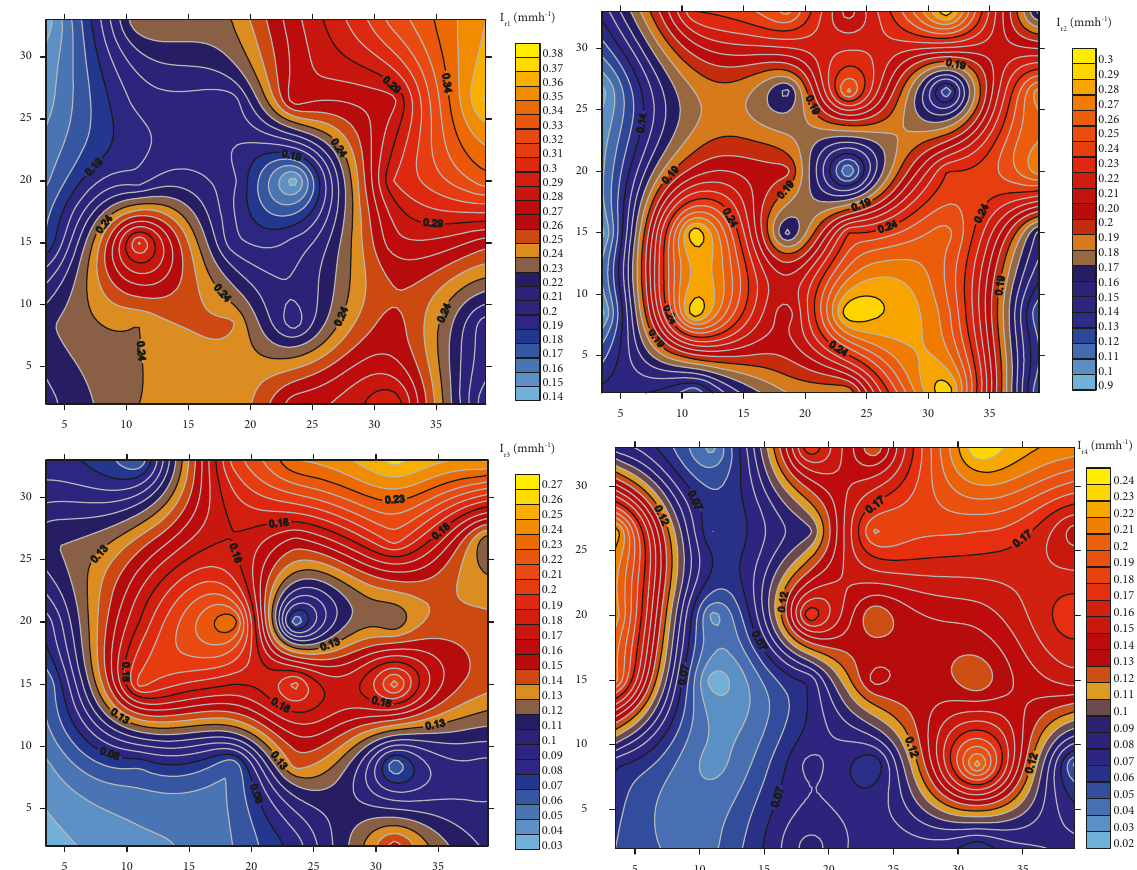
Figure 4: Spatial rainfall intensity distribution in the rainfall simulator with the different rainfall intensity ( I � Relative rainfall intensity).